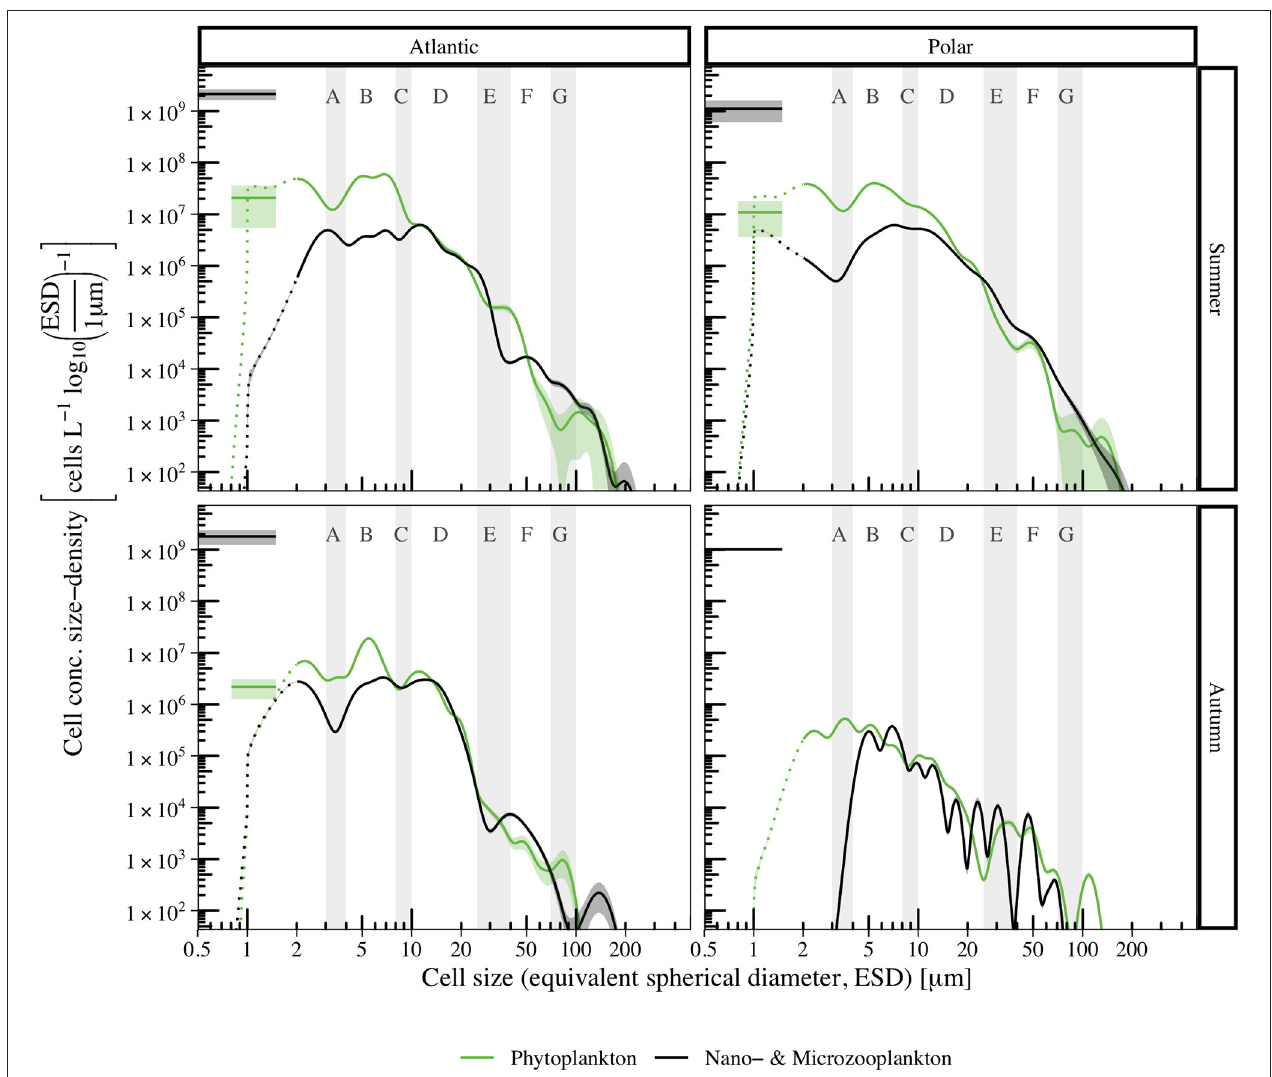
FIGURE 6 | Abundance size spectra for phyto- (green) and microzooplankton (black) of temporally (summer, top panels; autumn, bottom panels) and spatially (Atlantic, left panels; Polar, right panels) separated data. Colored shaded areas indicate the 95% confidence intervals, dotted lines indicate reduced reliability of size measurements for cells with ESD < 2 µ m. For comparison, cell concentration densities derived from Flow Cytometry measurements are shown for bacteria (black line, 0.5–1.5 µ m, data from corresponding samples in von Jackowski et al. (2020) and for Synechococcus (green line, 0.8–1.5 µ m, data from Paulsen et al., 2016; August-south ∧ Summer-Atlantic, August-north ∧ Summer-Polar, November ∧ Autumn-Atlantic). = = = TABLE 4 | Average and [minimum value, maximum value] total cell concentrations and total biovolumes for a spatio-temporally separated dataset. Season Region Type Cell conc. [ × 10 6 cells ] Biovol. [ mm 3 L L